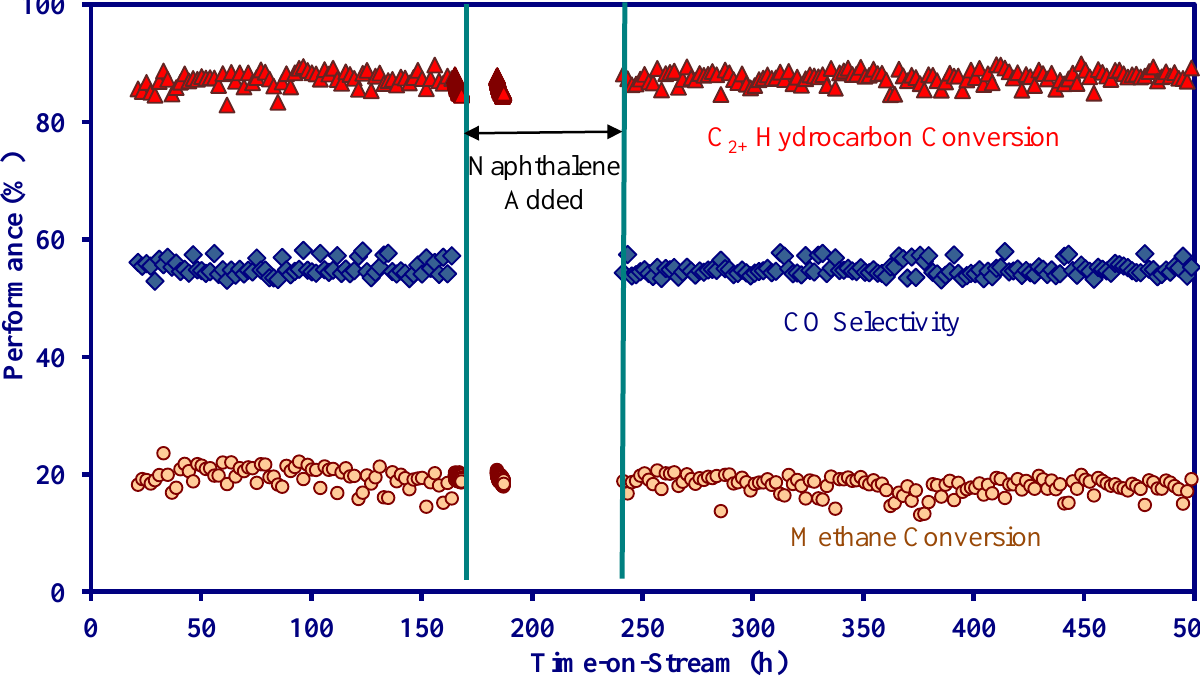
Figure 7. Reforming of biomass gasification products on a MNS-washcoated cordierite monolith in the presence of H 14.4% H , 10.4% CO, 9.8% CO 2